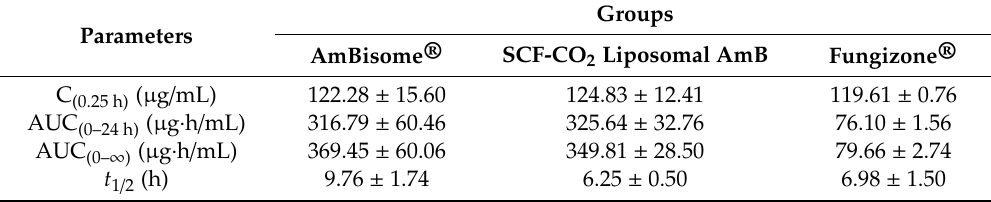
Figure 9. Plasma concentration-time profile of commercial products (AmBisome ® and Fungizone ® ) and the SCF liposomal AmB after administration as a single dose of 3 mg / kg by a tail vein injection. Data are expressed as the mean standard deviation ( n = 4). Table 5. Comparative in vivo pharmacokinetics parameters observed in rats ( n = 4).